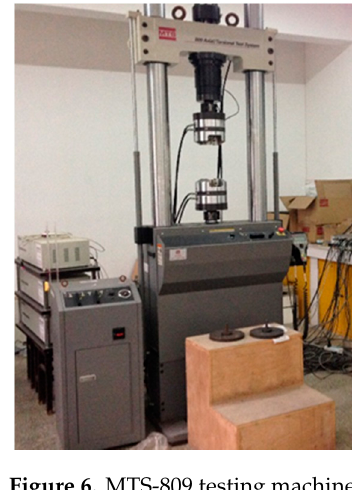
Figure 6. MTS-809 testing machine.